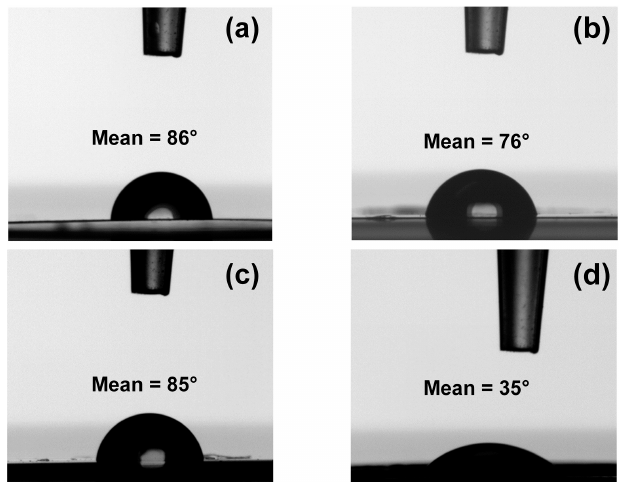
Figure 8. Water droplets on the surface of ( a ) TPEQ-ODPA; ( b ) TPEQ-ODPA-S; ( c ) PMDA-ODA; and ( d ) PMDA-ODA-S after 1 s contact time.